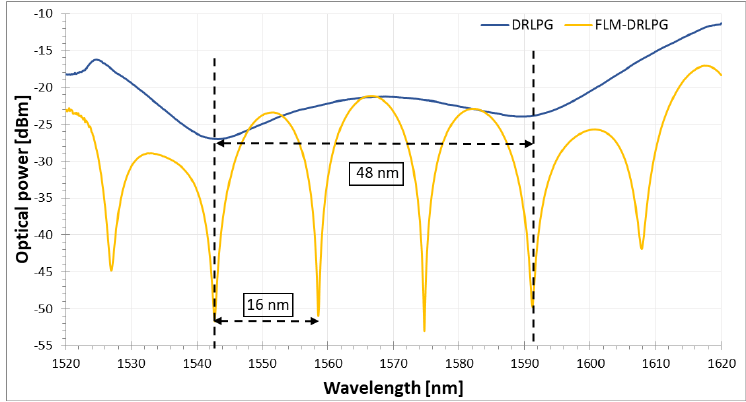
Figure 2. The transmission spectra of the dual-resonance long-period grating (DRLPG) (blue) and the DRLPG inside the fiber loop mirror (FLM) structure (yellow).